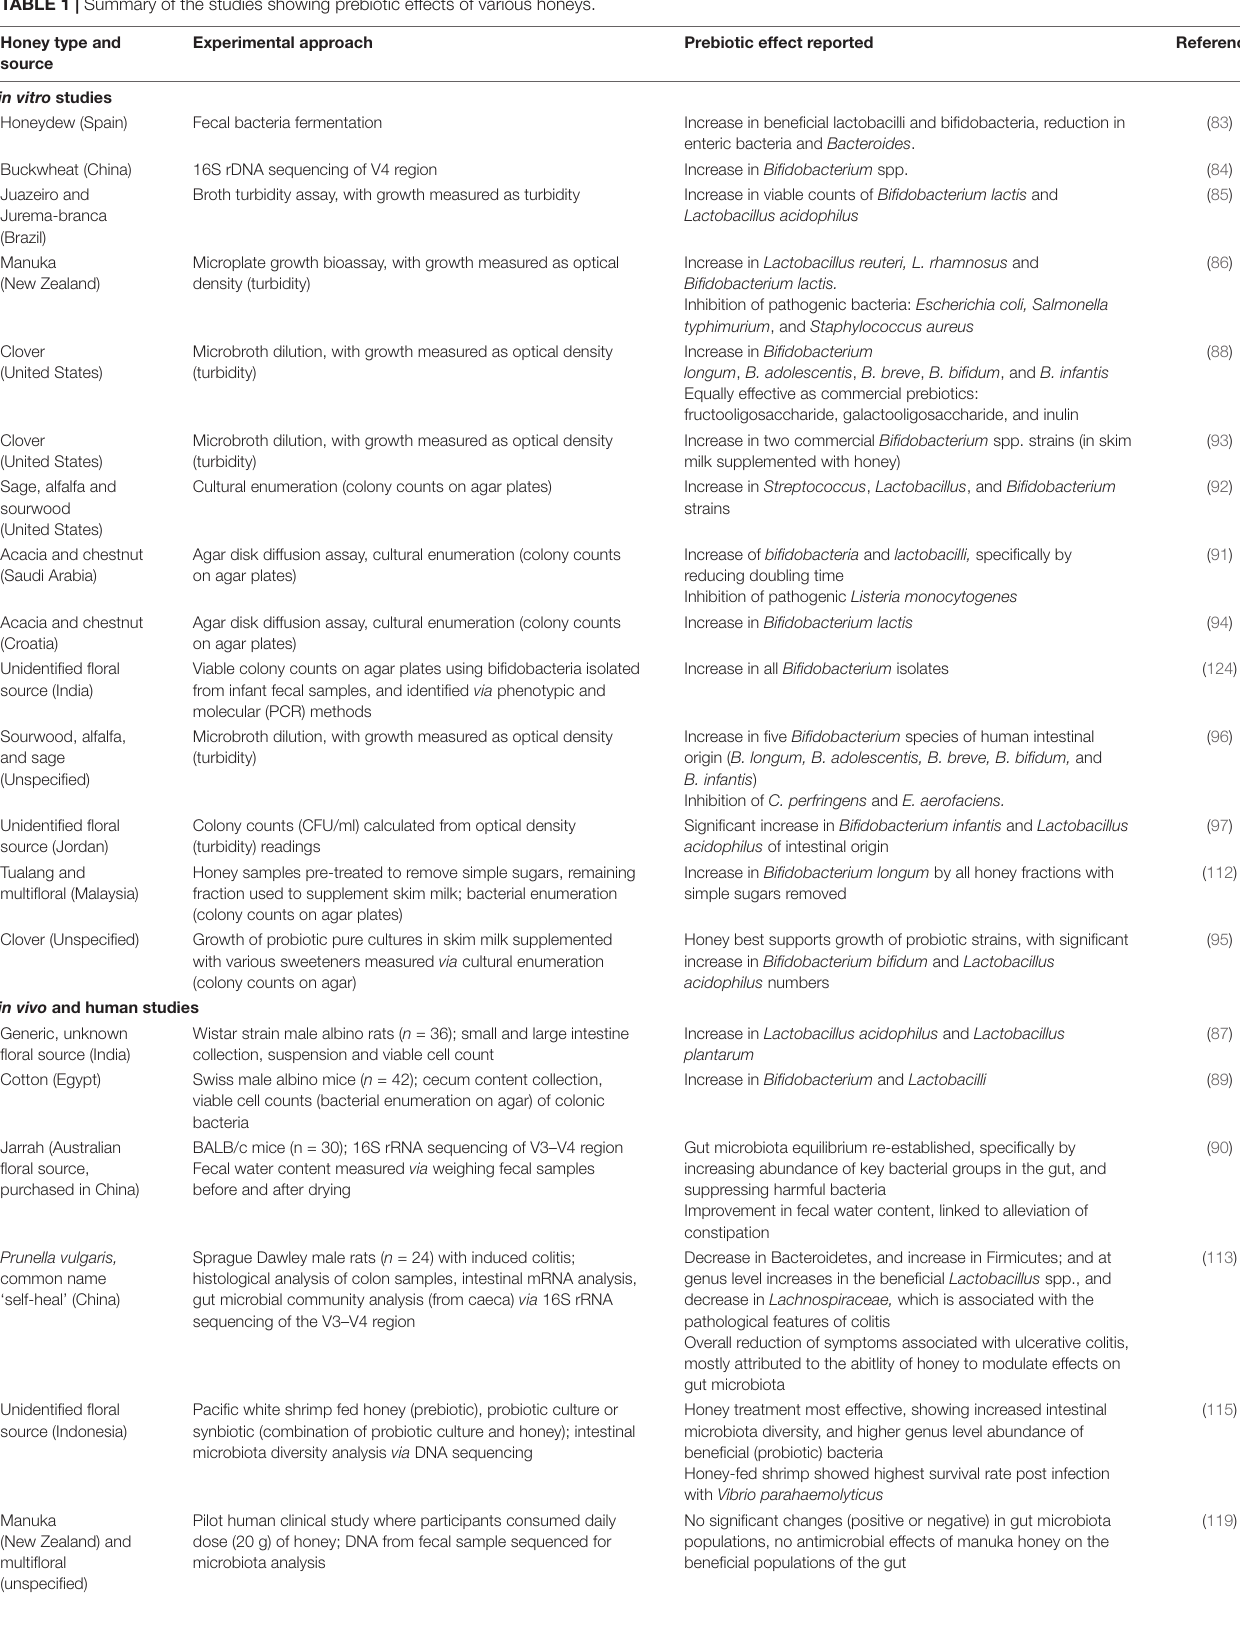
TABLE 1 | Summary of the studies showing prebiotic effects of various